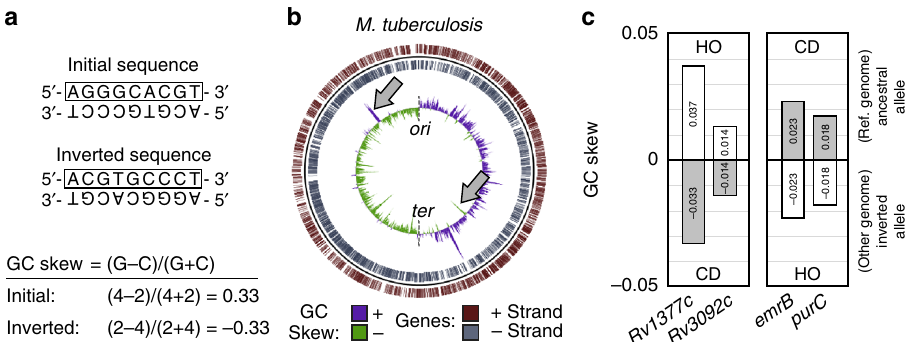
Fig. 1 DNA fragment inversion concomitantly inverts GC skew values. a The effect of DNA fragment inversion on GC Skew. An example DNA sequence oriented with the leading strand on top and its post-inversion form are depicted. The box indicates that the upper strand is used for GC skew calculation by convention. The GC skew calculation shows that the relative abundance of guanine and cytosine residues in the top strand are reversed upon DNA inversion, resulting in an inverse GC skew value. b GC skew values along the top strand are plotted on the M. tuberculosis H37Rv genome. GC skew values switch from positive (green) to negative (purple) at ori / ter regions due to opposing replication fork orientations. Inversions are apparent as deviations from strand averages (two examples are indicated by gray arrows). c Anecdotal examples of four genes that naturally inverted in speci fi c Mtb strains as identi fi ed by closed genome analysis. The ancestral orientation of each allele is indicated above the corresponding column (HO or CD) as inferred from the positive GC skew value. Columns are marked with GC skew values. Gene names are indicated under each column. Inverted alleles (always with both opposing orientations and GC skew values) were found in the following strains: Gene Rv1377c : Strain KIT87190, Gene Rv3092c : Strain F1, Genes emrB and